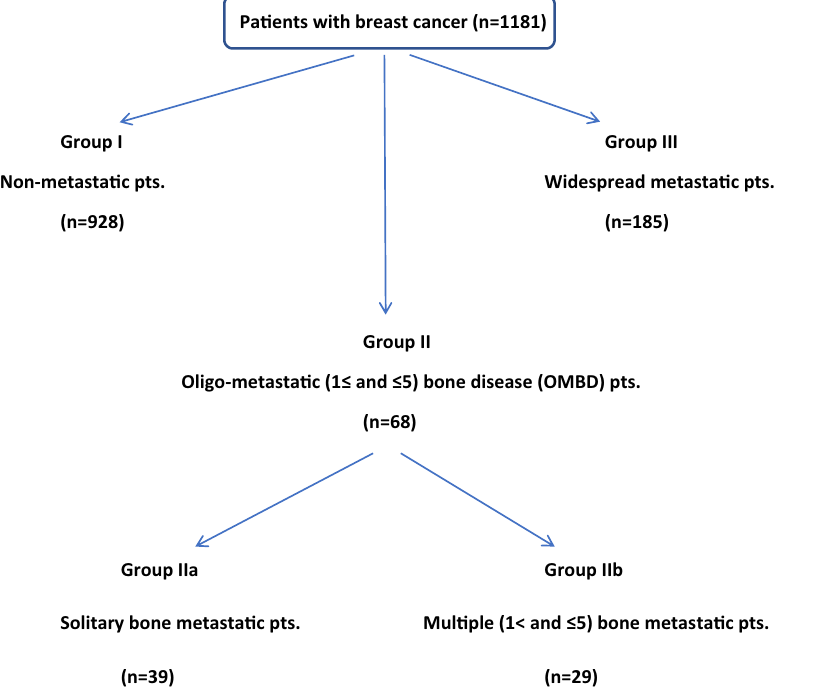
Figure 1. Patient groups in this study. GROUP I: non-metastatic group. GROUP II: oligometastatic bone disease (OMBD) = oligo-bone metastasis group = single bone metastases (SBM). (IIa) Patients with solitary bone metastasis = Only one bone met. (IIb) Patients with oligo bone metastasis = More than one but fewer than five bone metastases. GROUP III: Widespread metastatic disease = solid organ metastasis and/or multiple (more than five) bone metastasis